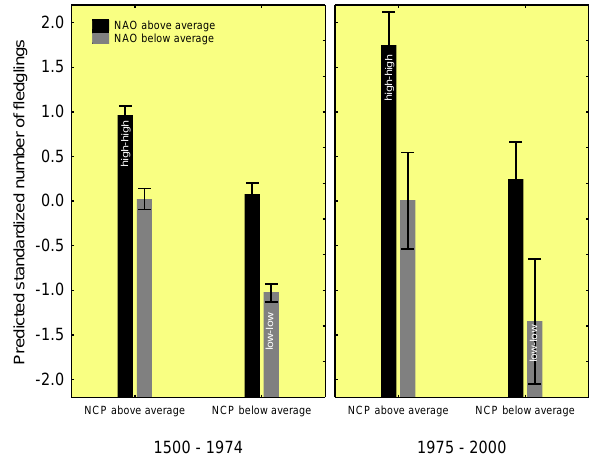
Figure 5. Effects of high and low states of the NAOI and NCPI on the predicted annual fecundity of great tits 1500 – 1974 and 1975 – 2000, respectively (retrospective model). Coinciding high states (indices > 0) of both oscillations favoured markedly increased predicted annual fecundity. When both states were low (indices < 0) predicted fecundity was particularly low. After 1975, the effect was reinforced compared to the period 1500-1974. Coinciding high/high states indicate relatively warm and dry springs (see also fig. 2 and table 4). No significance tests were performed on predicted values. Bars give annual averages, whiskers denote 95% confidence intervals for means.